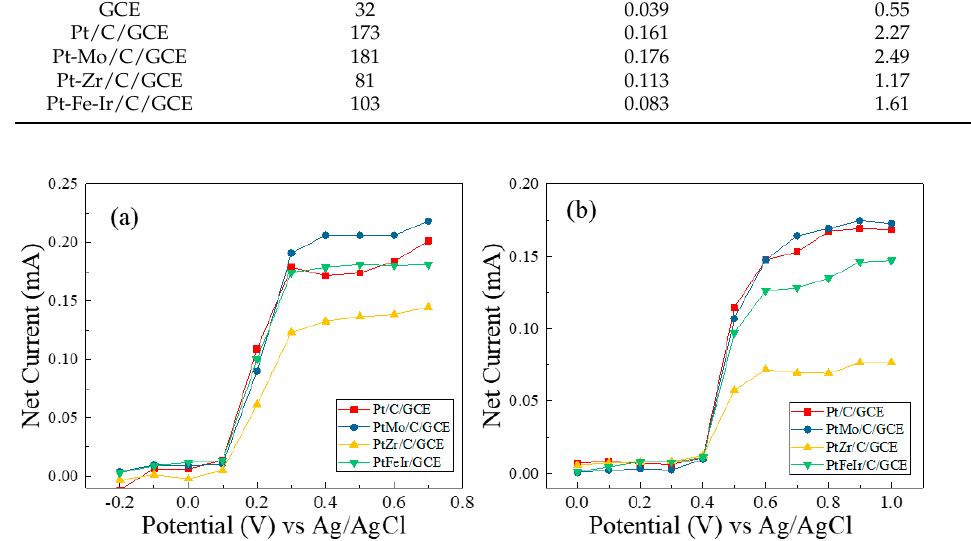
Figure 5. The polarization curves that were obtained by subtracting background currents for ( a ) 15 mM AA;